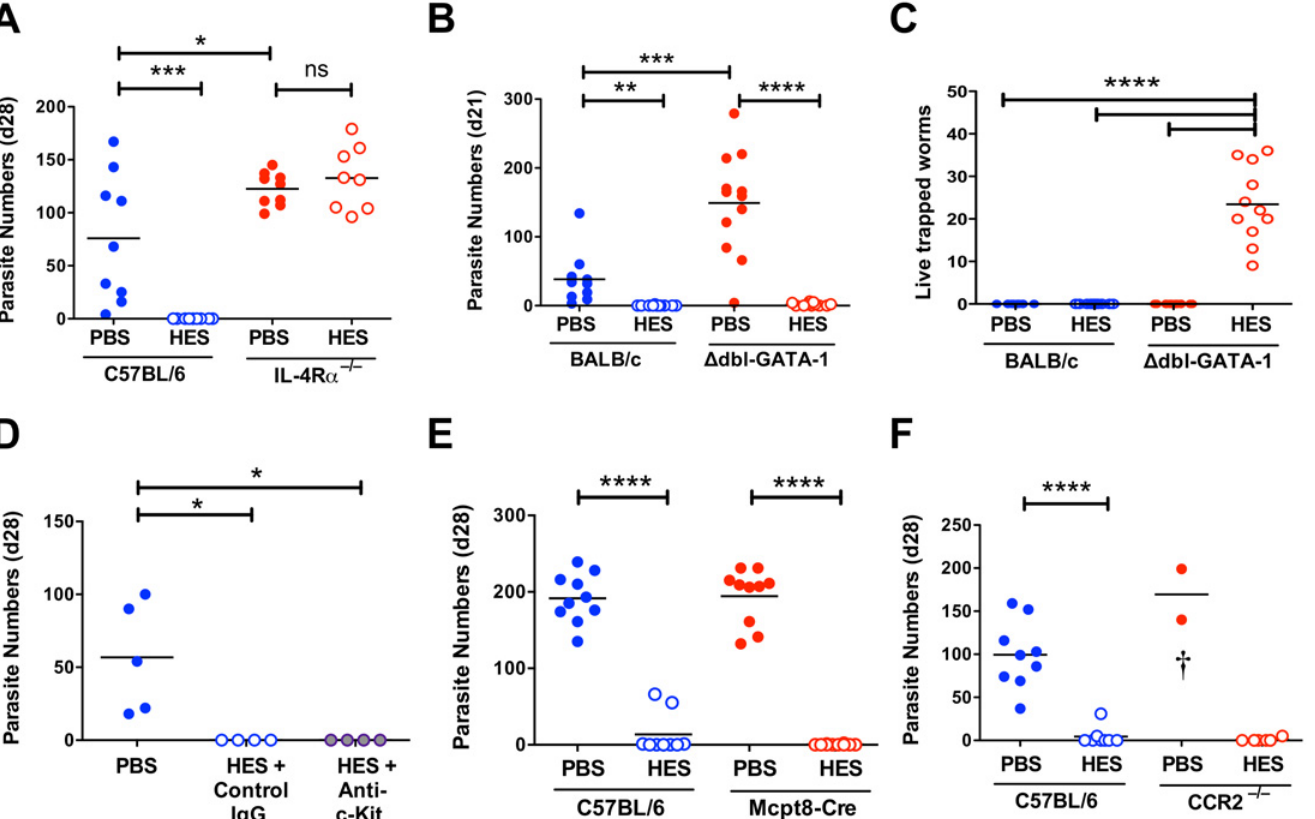
Fig 4. Vaccine-induced immunity requires IL-4R-mediated signaling but not eosinophils, mast cells, basophils or CCR2+ monocytes. A-F . Day 21 – 28 worm counts in control and vaccinated (A) C57BL/6 and IL-4R α – / – mice, (B-C) BALB/c and GATA-1 Δ dbl mice, (D) ACK-2-treated and control C57BL/6 mice, (E) C57BL/6 4get/Mcpt8 cre and 4get controls and (F) CCR2 – / – and C57BL/6 controls. n.b. PBS/alum immunized CCR2 – / – mice died or were culled between 7 – 9 days post-challenge, with significant intestinal bleeding observed. Luminal worms in (A, B, D, E, and F), whereas counts in (C) represent live worms recovered from the intestinal wall at day 21 (i.e. presumed non-migratory parasites). Data in (A, B, C, E and F) pooled from 2 independent experiments. Significance in (A), (C) and (D) determined by ANOVA, in (B) by Kruskal-Wallis test, and (E-F) by unpaired t -test. See also S3